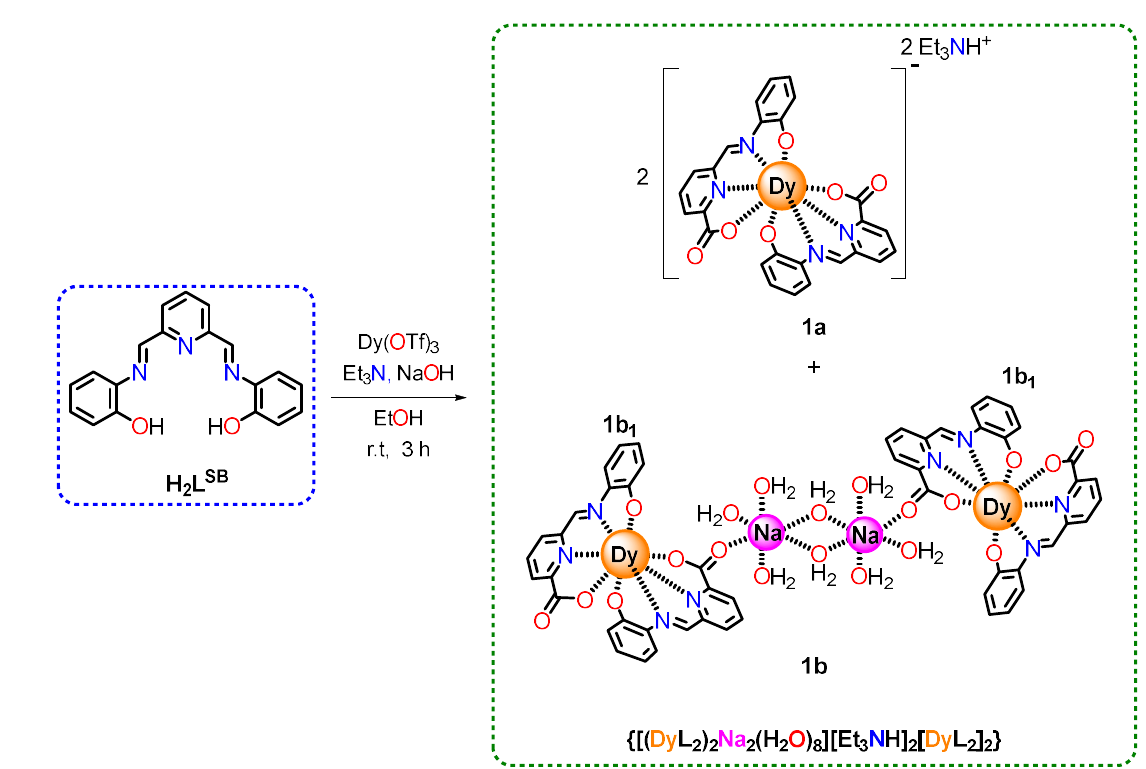
Scheme 1. Reaction scheme for the isolation of complex 1